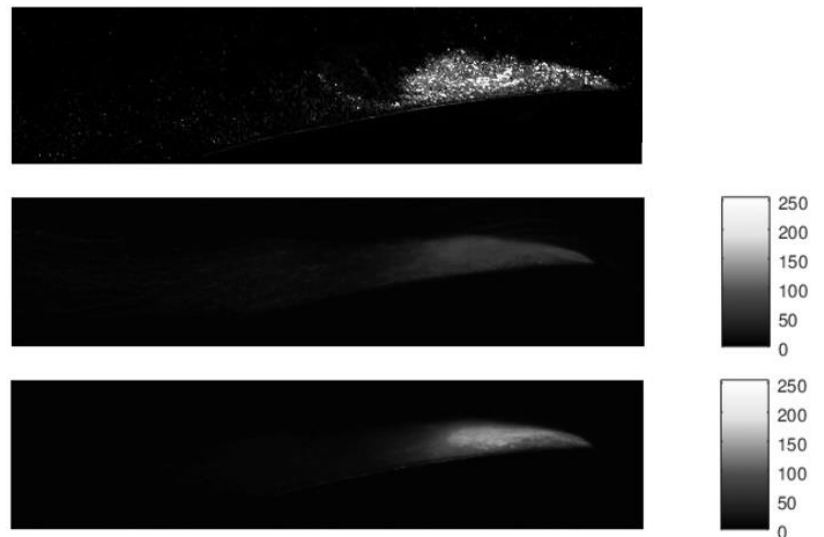
Figure 8. Original hydrofoil, a sample image of cavitation ( top ), spatially averaged grey level ( middle ), and standard deviation of grey level ( bottom ), operating point p = 0.15 bar, Q = 61.7 m 3 /h, and σ = 2.27.